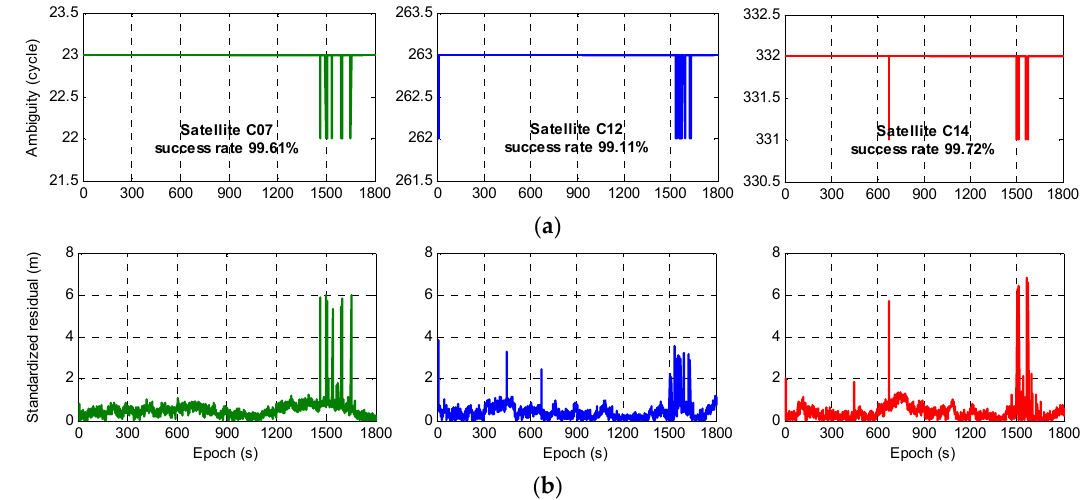
Figure 6. Performance of fixed ambiguity ( a ) and standardized residuals ( b ) for satellites C07, C12, and C14.